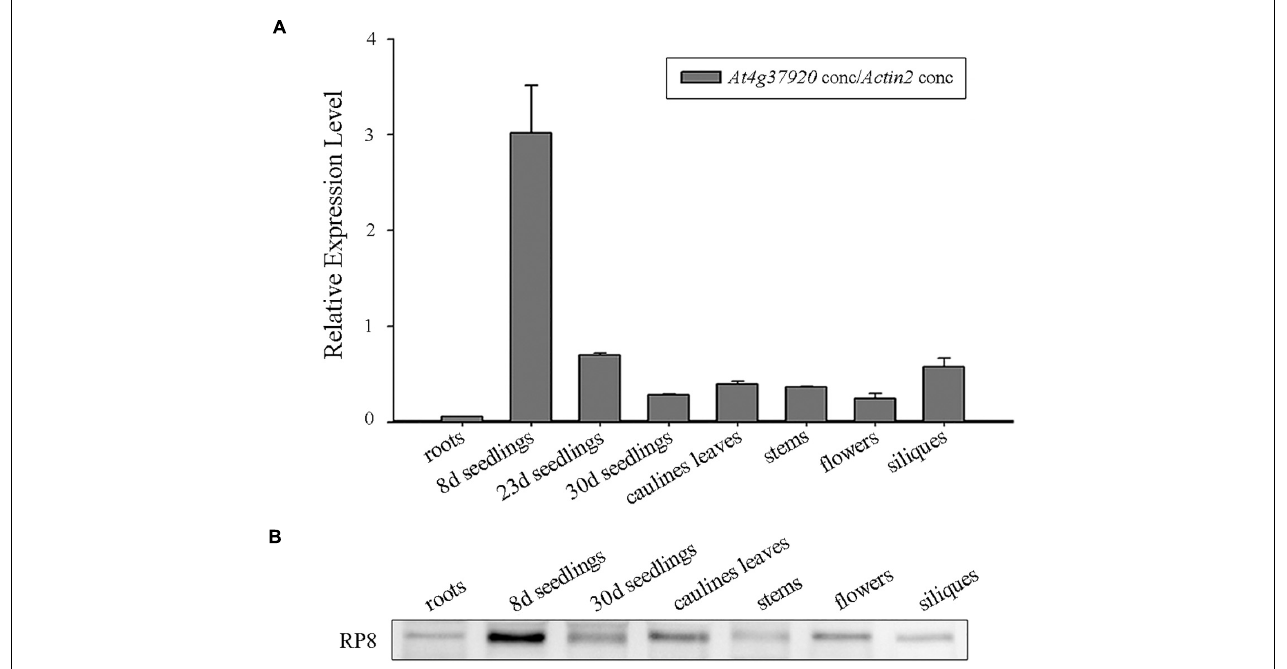
FIGURE 3 | Expression analysis of the RP8 gene. (A) Relative expression of the RP8 gene in different tissues of Arabidopsis . Total RNA was extracted from various tissues of the wild type and RT-qPCR was carried out. All values are means of three biological replicates with SD. (B) Detection of the RP8 protein in extracts of different tissues in Arabidopsis . Each lane was loaded with 15 µ g